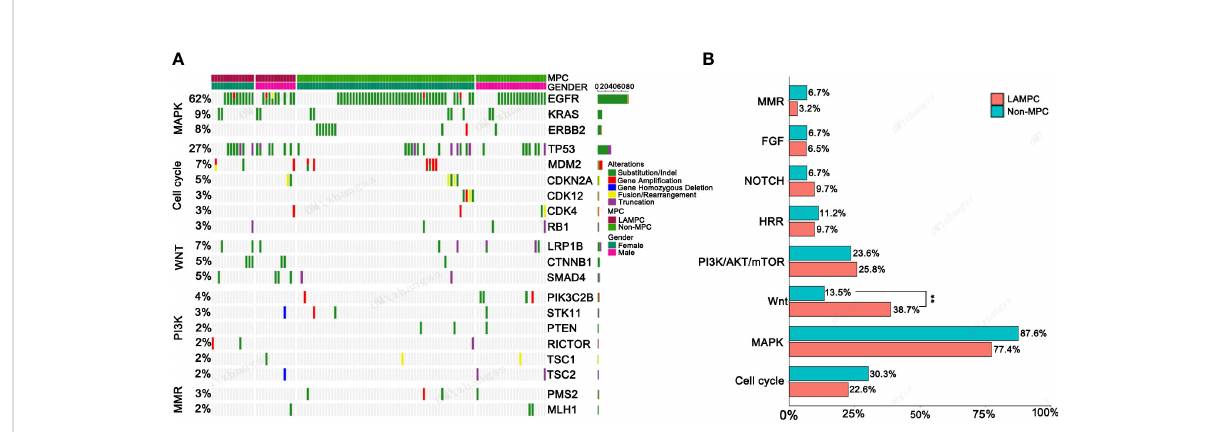
FIGURE 3 The genomic mutations involved in important signaling pathways in LAMPC and non-MPC patients. (A) The genomic alteration pro fi le of pathways between LAMPC and non-MPC patients. (B) A comparison of the frequency of pathway changes between LAMPC and non-MPC patients. ** p < 0.01.